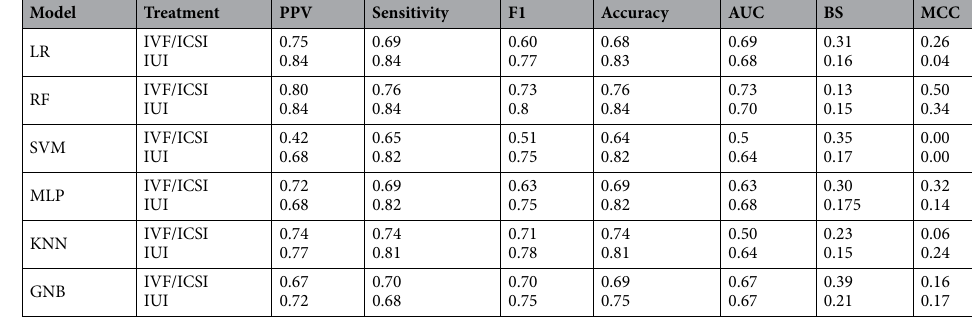
Table 1. Comparison among results of different prediction models with clinical pregnancy in IVF/ICS and IUI treatment. PPV, Positive Predictive Value; AUC, Area Under ROC Curve; BS, Brier Score, MLP, Multi-Level Perceptron; SVM, Support Vector Machine; LR, Logistic Regression; RF, Random Forest; KNN, k-Nearest Neighbor; GNB, Gaussian Naïve